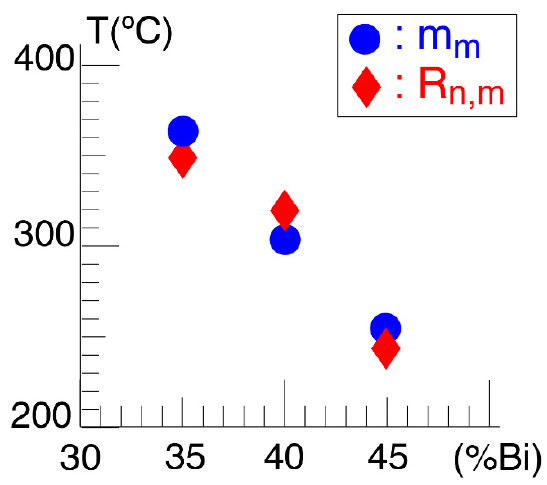
Figure 7. Temperatures of the maximum slope of the resistance drop ( R n,m ) and estimated temperatures where half of the total magnetic moment of the samples ( m m ) was formed. The former temperatures are represented as a function of the atomic content of Bi in the samples.